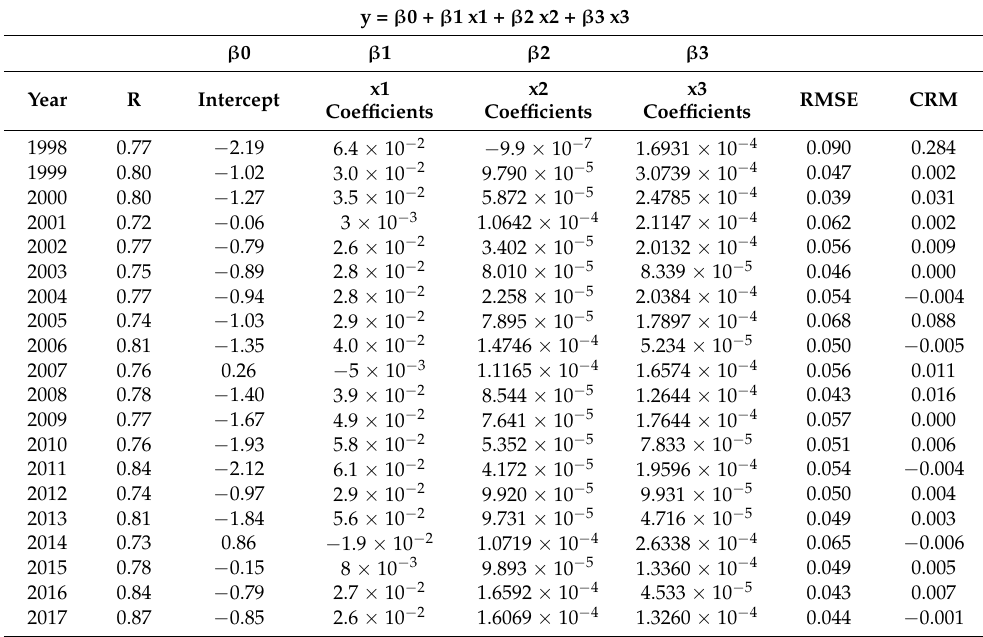
Table 8. Parameters of the regression models used for predicting drought index (NDVI) in the